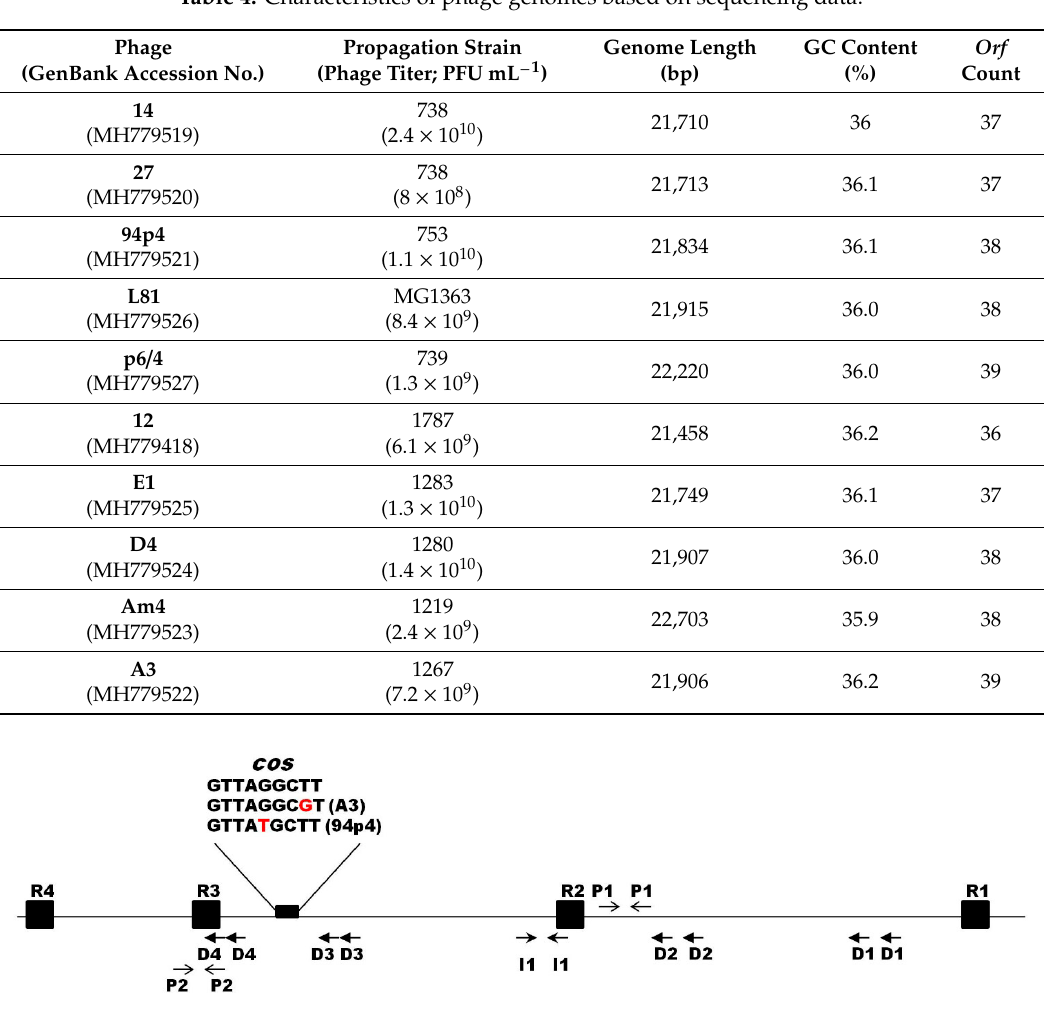
Figure 4. Schematic representation of the cos region of the sequenced Ceduovirus phages. A small black rectangle marks the position of the cos site, and its 9-nt sequence is given above (differences in nucleotides are marked in red); black squares (R) mark putative terminase binding sites; arrows depict palindromic sequences (P), direct (D), and indirect (I)